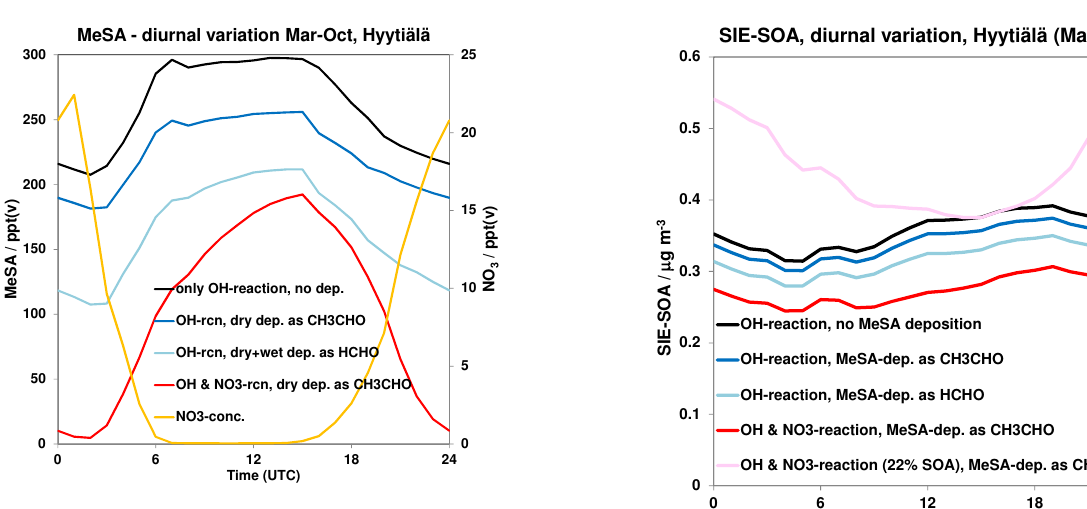
Figure 6. Modelled diurnal variation (average for the period Mar– Oct) of methyl salicylate (MeSA) at Hyytiälä (Finland), using the Case 2 scenario for biotic stress-induced emissions. Comparison of model runs with four different assumptions regarding deposi- tion losses and NO 3 -reactivity of MeSA. Black curve: only OH reaction, no deposition of MeSA; dark blue: OH reaction, dry de- position of MeSA with the same deposition velocity as acetalde- hyde; light blue: OH reaction, wet and dry deposition of MeSA with the same treatment as formaldehyde; red: NO 3 reaction ( k = 5 . 4 × 10 − 13 cm 3 molecule − 1 s − 1 ), OH reaction, dry depostion as acetaldehyde. The modelled concentration of NO 3 is also shown (orange curve, right axis). Unit: ppt(v).